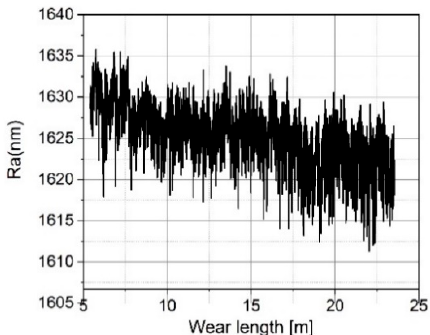
Figure 23. Measured arithmetic mean roughness values Ra on the roughness standard RN 6678 versus measurement length.